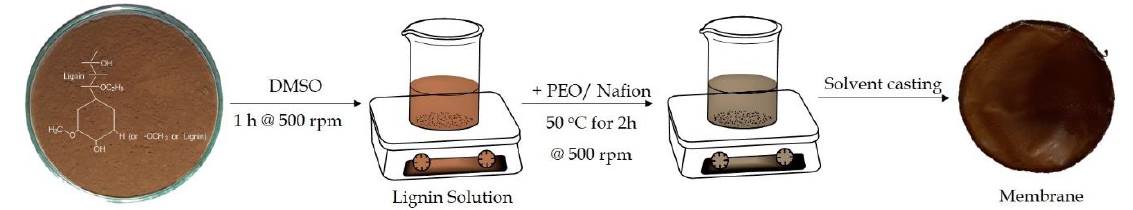
Figure 2. Illustration of the preparation process of Lignin based composite membranes. The obtained dried membranes, light brown to darker brown in color, were punched out into 20 mm discs to be used as working electrodes in electrochemical characterizations. The mixture containing a higher percentage of lignin resulted in a thick gel to hard rock pieces, which were difficult to manage and analyze.